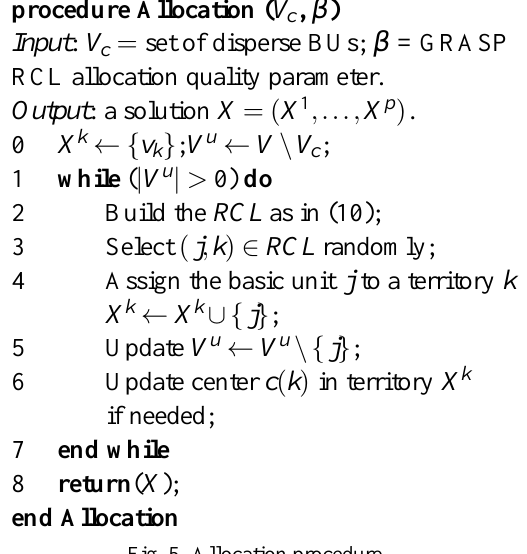
Fig. 5. Allocation